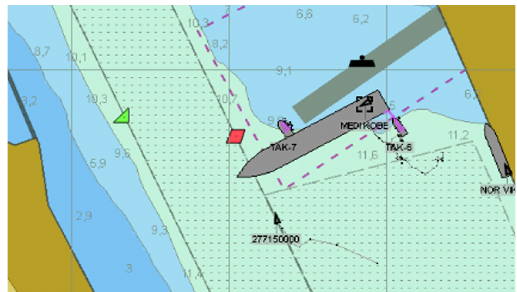
Fig. 13. Bulk ship MEDI KOBE mooring in the crosscurrent with 2 tugs in the bow and 1 tug in the astern (every tug bollard pull is equal to 500 kN)